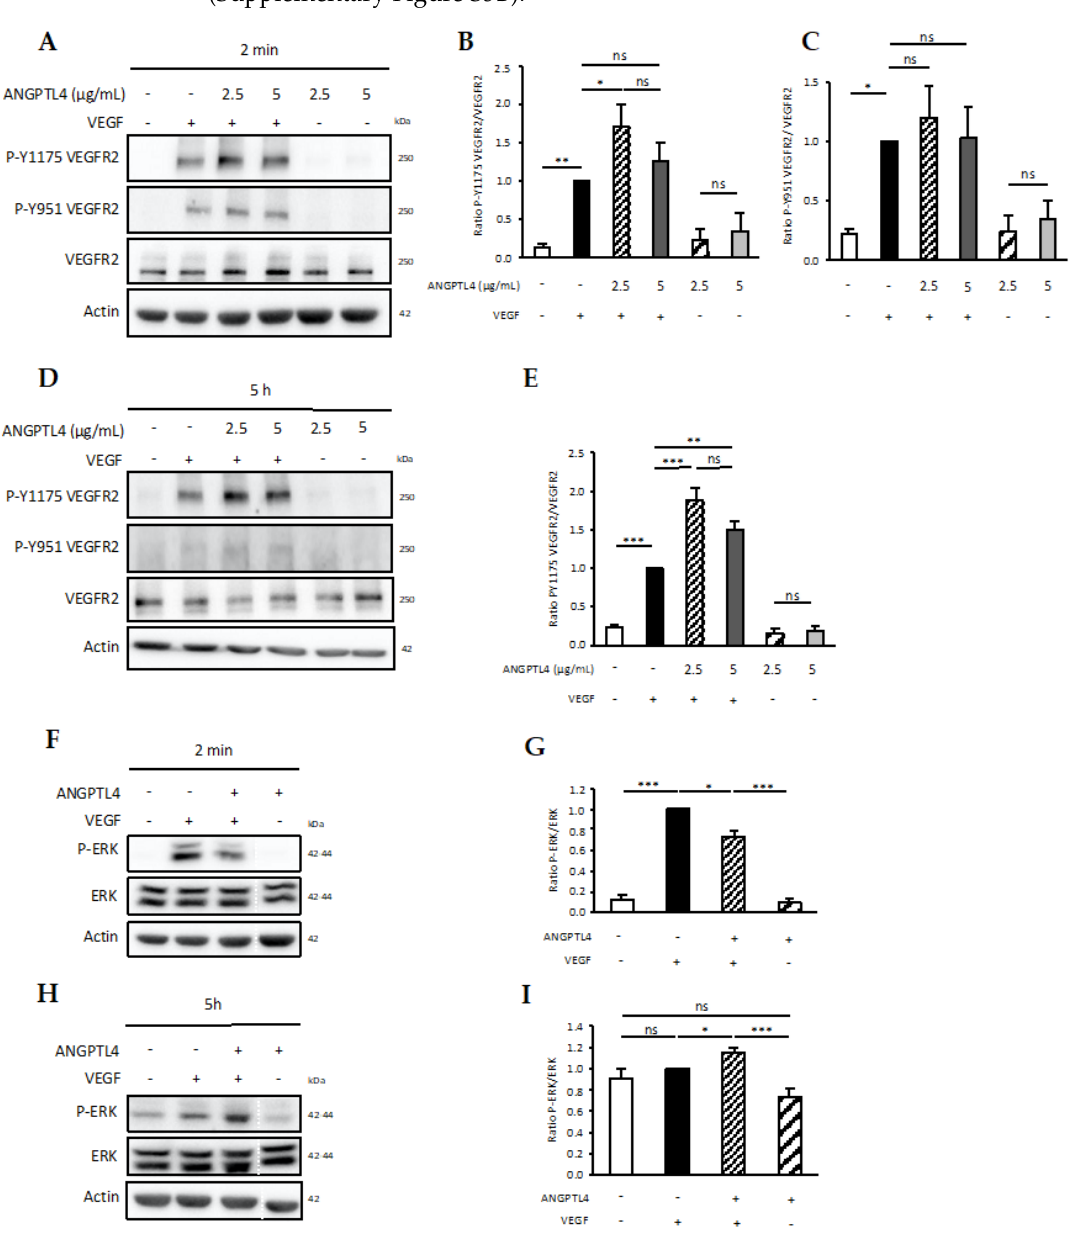
Figure 6. Short- and long-term regulation of VEGFR2 signaling. Endothelial cells were stimulated without or with ANGPTL4 (2.5 or 5 µg/mL) and/or VEGF (50 ng/mL). Phosphorylation of VEGFR2 at tyrosine sites 951 and 1175 was analyzed after 2 min ( A – C ) or 5 h ( D,E ) stimulation. Phosphorylation of ERK was analyzed after 2 min ( F , G ) or 5 h ( H , I ) treatment by ANGPTL4 (2.5 µg/mL) and/or VEGF (50 ng/mL). Immunoblots are representative of several independent experiments (3 for B , E , G and I ; 5 for C ). Blot image cuts are indicated by dotted white lines. Actin immunoblot was used as loading control. Graphs represent mean values (+SEM) of the ratio of phosphorylated protein over total protein. Individual values are normalized to the mean value of VEGF condition for each experiment. ns: p > 0.05, * p ≤ 0.05, ** p ≤ 0.01, *** p ≤ 0.001 (one-way ANOVA).